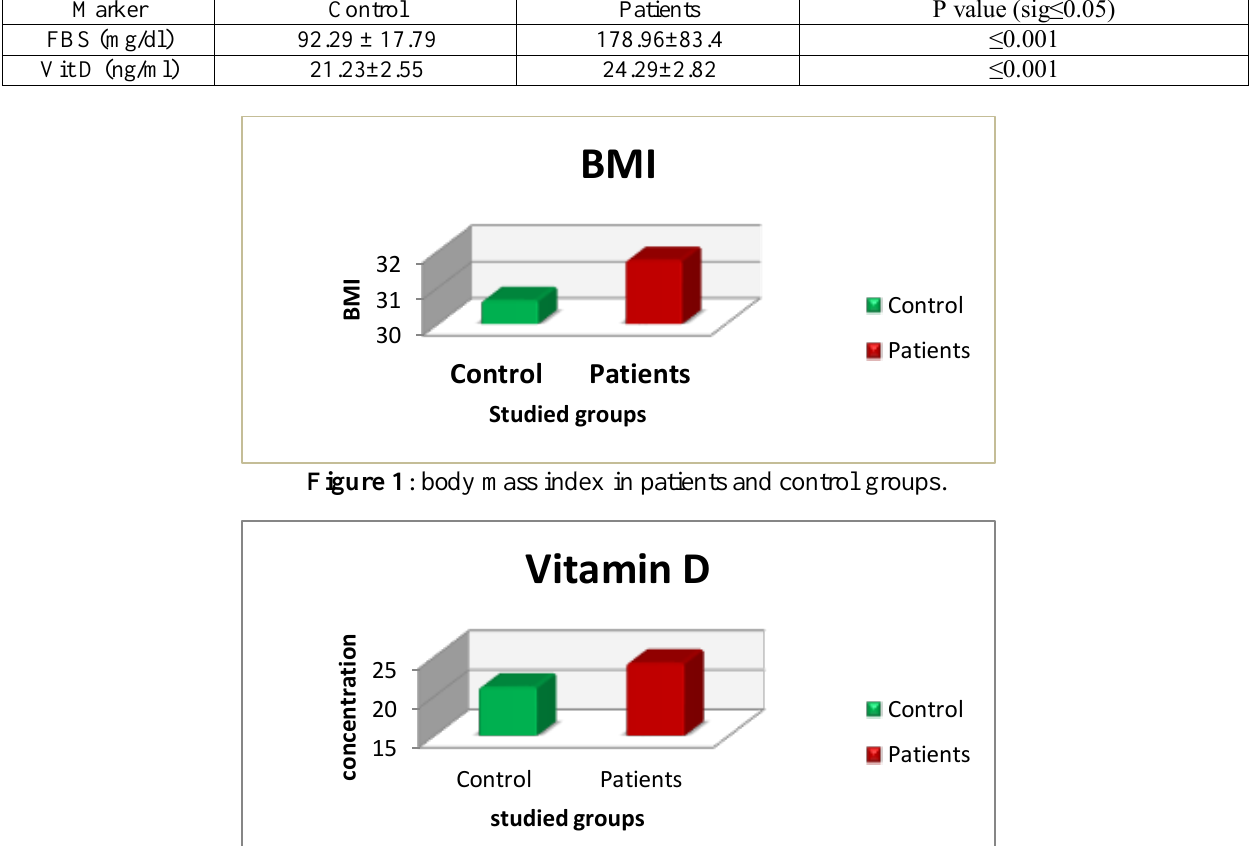
Table 2: Fasting blood sugar and vitamin D levels in patients and control groups.